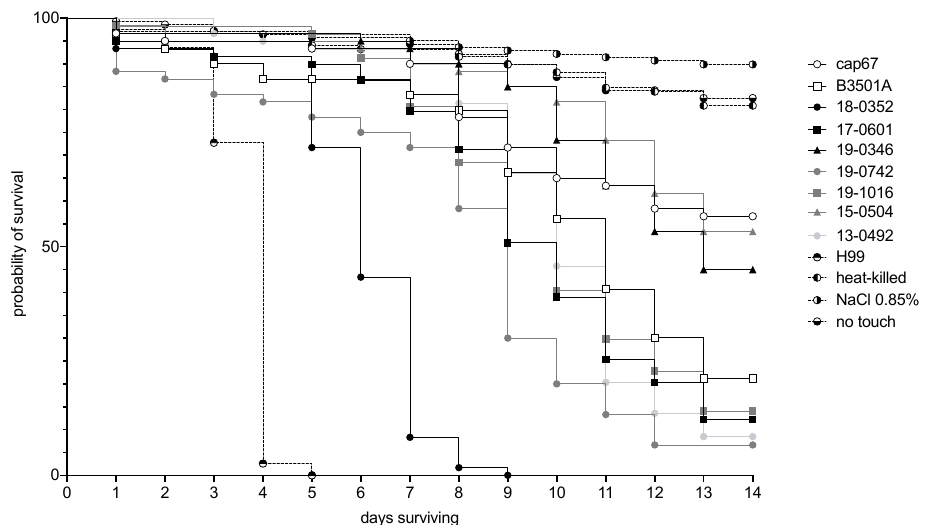
Figure 7. Virulence of C. neoformans var. neoformans isolates in the G. mellonella injection model. Kaplan–Meier survival curves demonstrate that isolates recovered from human infections, either disseminated infections (black), localized soft tissue infections (grey), or environmental isolates (light grey), show substantial differences in virulence. While all C. neoformans var. neoformans isolates show longer median survival compared to C. neoformans var. grubii H99, they show shorter median survival than cap67, a strain lacking a capsule that was demonstrated to be avirulent in mice (40, 41). Each symbol represents a tested isolate; dashed lines represent control groups. Each curve represents cumulative data of three biological replicates with 20 larvae per group and experimental unit.